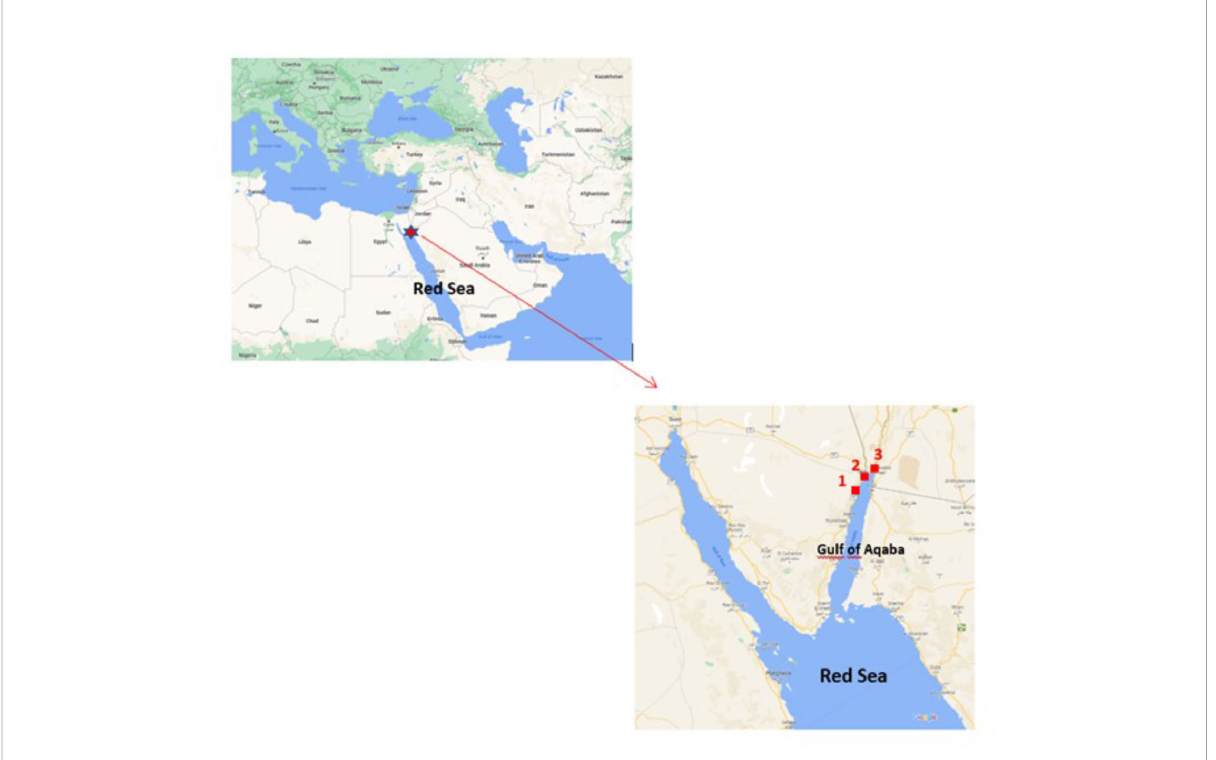
FIGURE 1 Map showing the beaches sampled in the Gulf of Aqaba, north Red Sea: 1: Hahashmal, 2: The Red Rock and 3: Neviot. Source: modi fi ed by the authors from Google